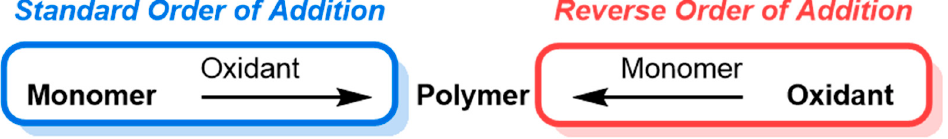
Figure 2. Differences between standard and reverse addition in chemical oxidative polymeriza- tion.